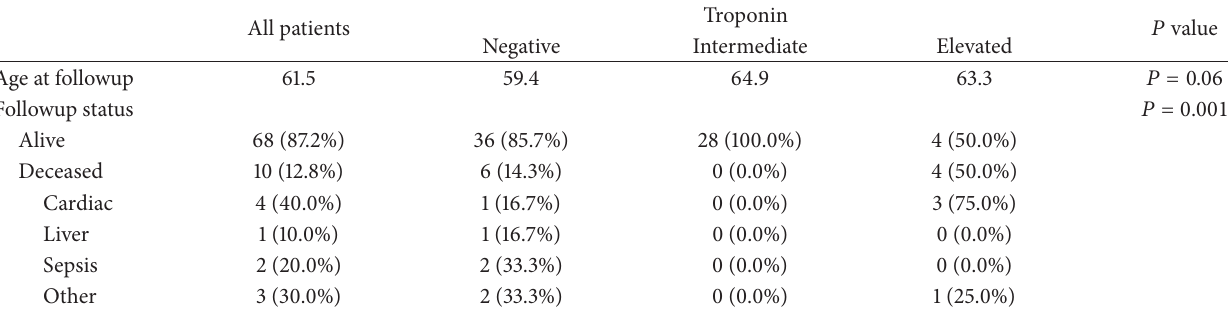
Table 4: Comparison of patient status following